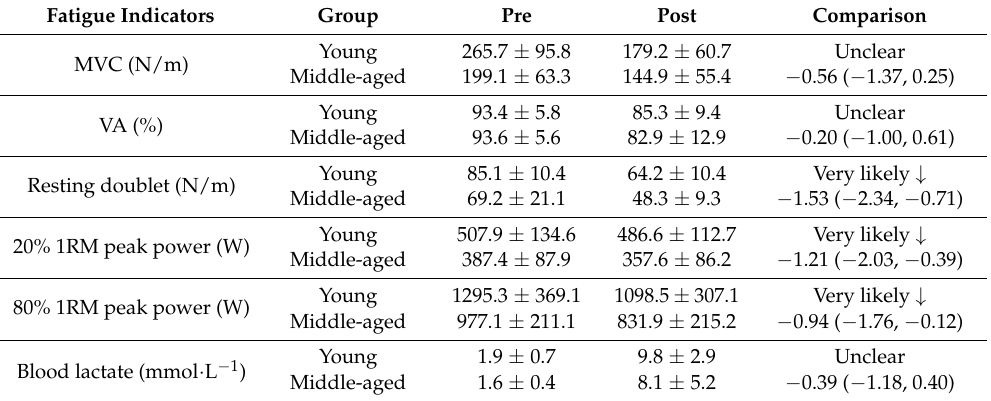
Table 3. Markers of fatigue (mean ± SD) in after squatting exercise in young and middle-aged males. Qualitative descriptor, effect size, and upper and lower 90% confidence intervals are noted in the effect size column.